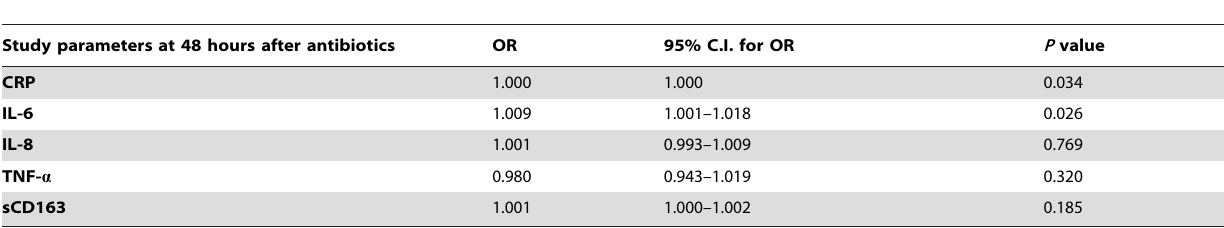
Table 9. Prognostic predictors of neonatal sepsis 48 hours after initiation of antibiotic therapy.